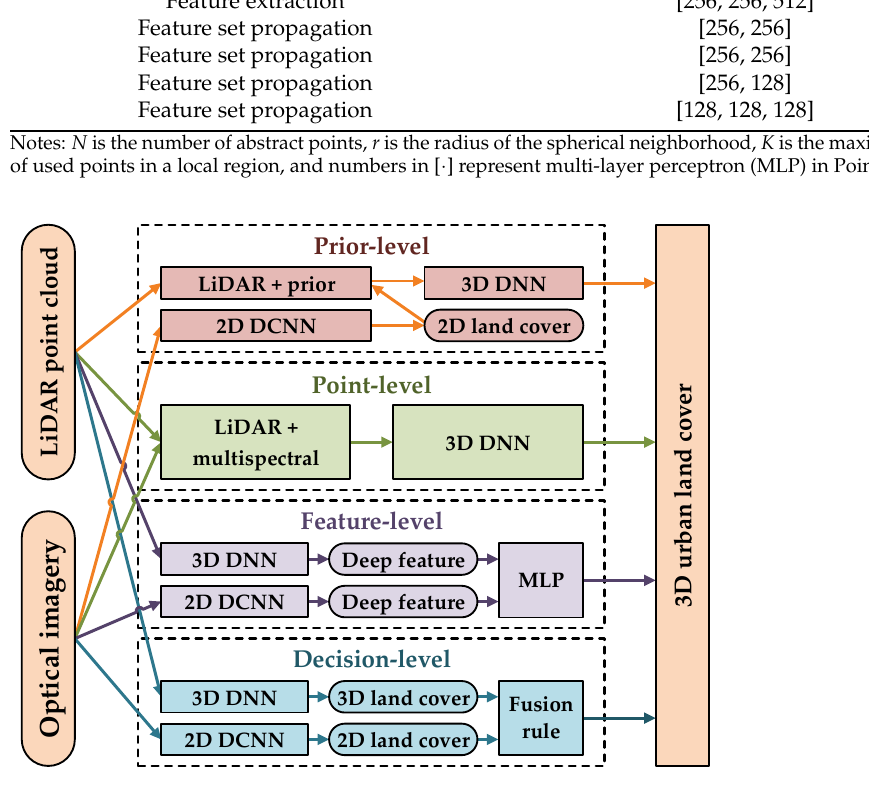
Figure 3. Four fusion strategies for LiDAR point cloud and optical imagery for three-dimensional (3D) urban land cover classification.